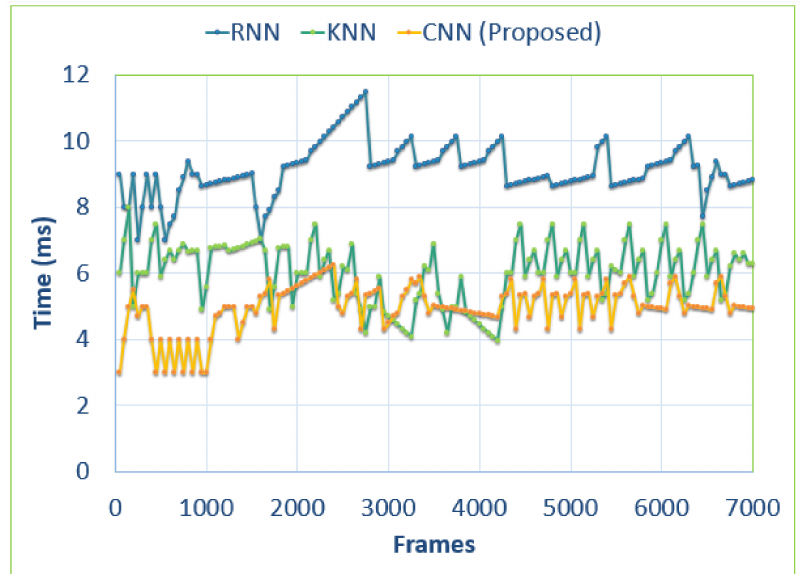
Figure 15. Comparison of the computational efficiency of our proposed model with other state of the art models over the PCDS